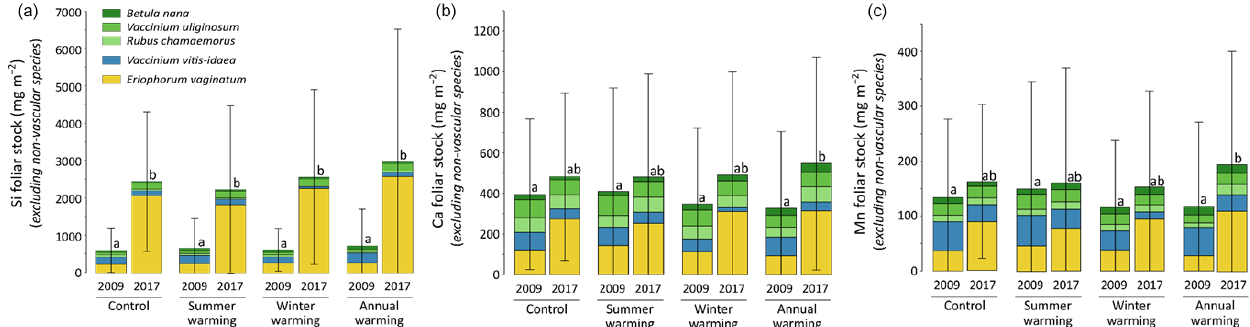
Figure 4. Evolution over time of the cumulative foliar stocks (mgm − 2 ) of (a) silicon, (b) calcium, and (c) manganese into five vascular plant species between the four warming treatments of the experimental site (CiPEHR). Vegetation is sorted by plant functional types: deciduous shrubs and forbs (green), evergreen shrubs (blue), and sedges (yellow). Elemental content of mosses and lichens was not measured at the CiPEHR site. The four treatments (control, summer warming, winter warming, and annual warming) refer to no artificial treatment, air warming, soil warming, and both air and soil warming, respectively. Letters correspond to a mixed-effects model analysis and compare the total foliar elemental stocks between warming treatments and years. Error bars represent standard